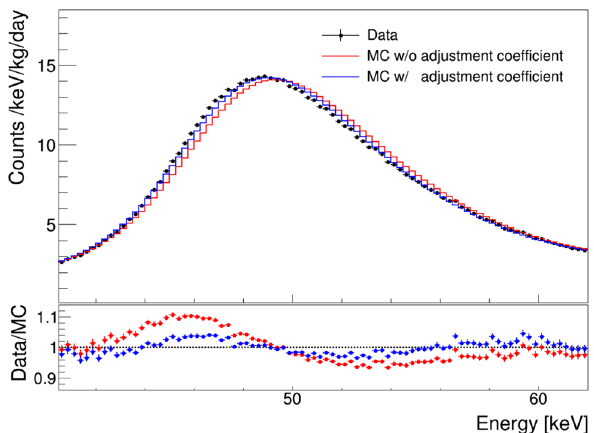
Fig. 6 Top panel shows Crystal 6 energy spectra of single-hit events in the low energy region. Black dots are data and the red (blue) line shows the total MC without (with) application of the adjustment coefficient in the background modeling fit. In the bottom panel, the red (blue) dots are the ratio of data to MC without (with) application of the adjustment